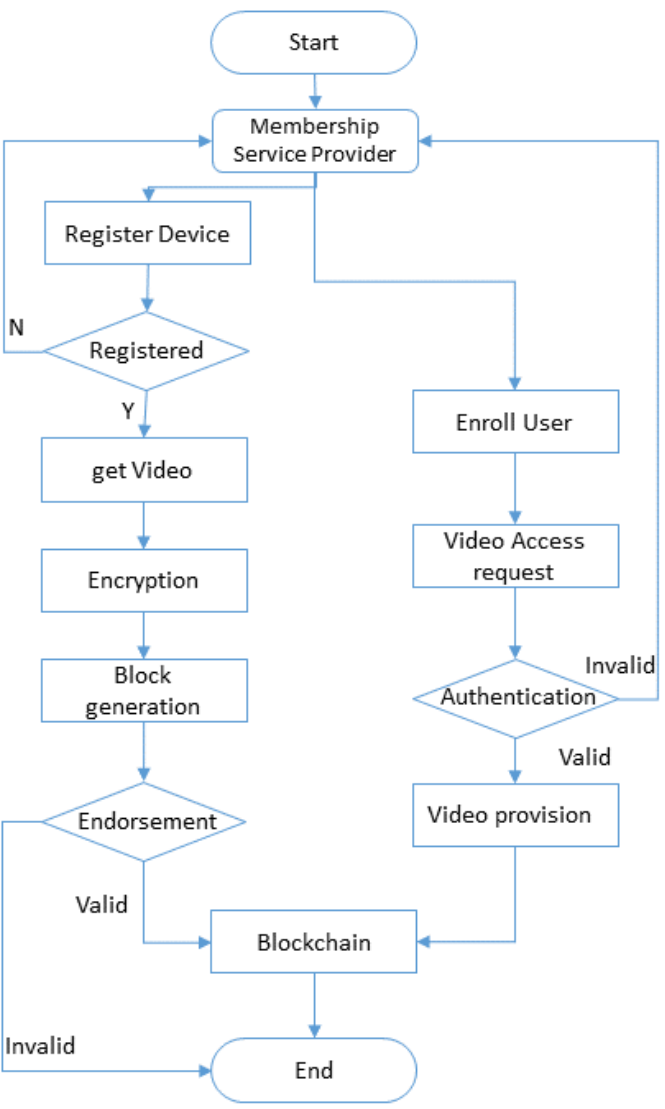
Figure 1. Flowchart of the proposed